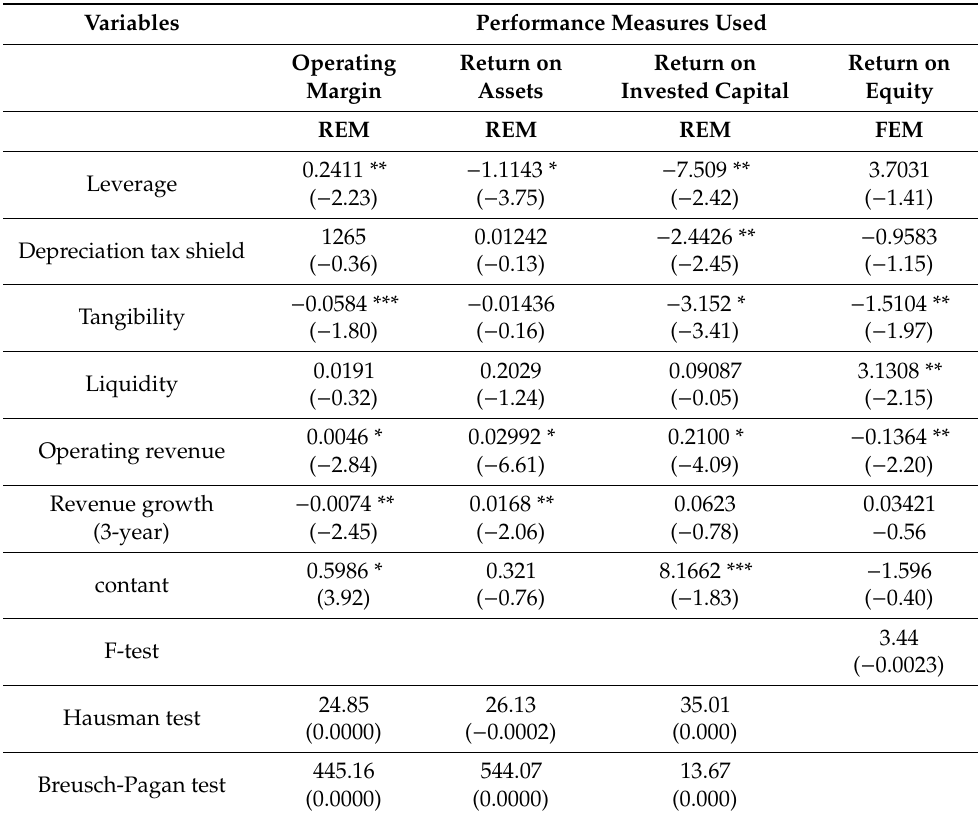
Table 8. Leverage and its e ff ect of firm